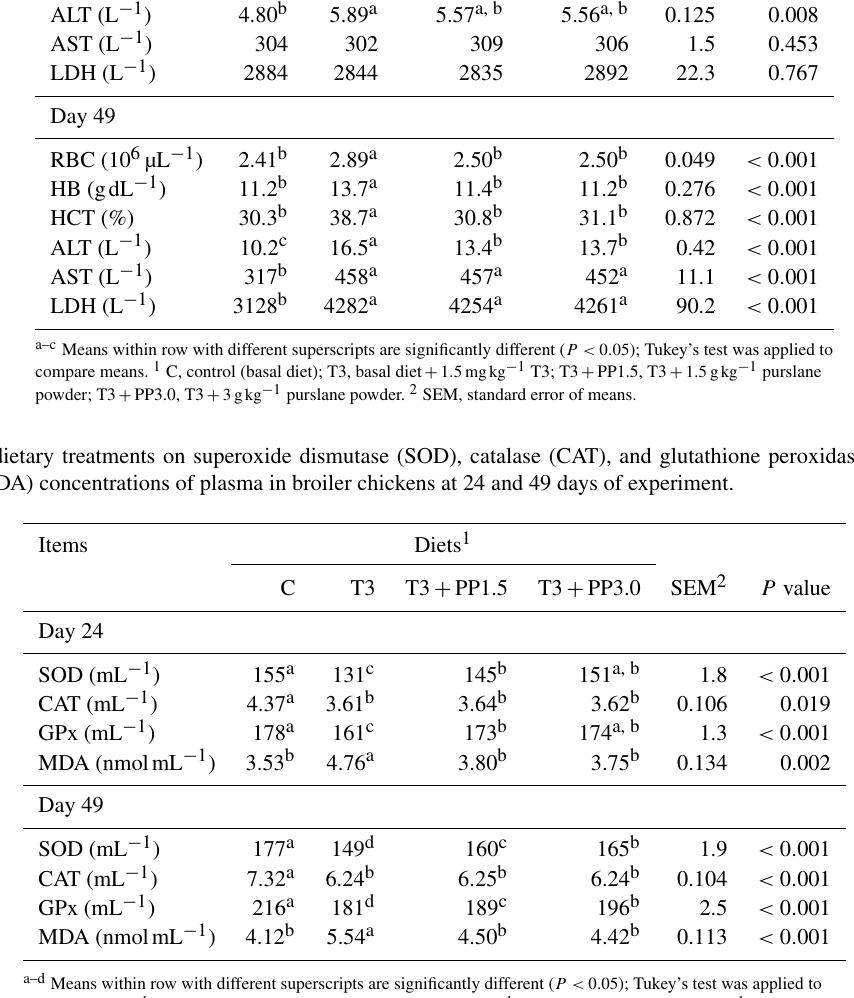
Table 4. Effects of dietary treatments on red blood cell counts (RBC), hemoglobin (HB), and hematocrit (HCT), and plasma activities of alanine aminotransferase (ALT), aspartate aminotransferase (AST), and lactate dehydrogenase (LDH) in broiler chickens at 24 and 49 days of experiment. Items Diets 1 C T3 T3 + PP1.5 T3 + PP3.0 SEM 2 P value Day 24 RBC (10 6 µL − 1 ) 1.78 b 2.27 a 2.10 a, b 1.97 a, b 0.054 0.005 HB (gdL − 1 ) 8.74 b